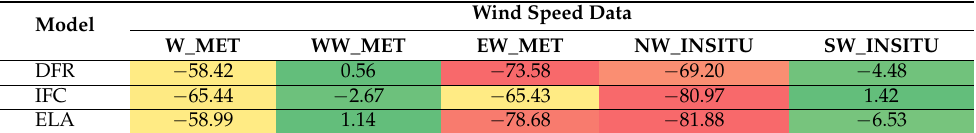
Table 4. MBE values for each combination in P_1_T. The colors of the scale refer to each row, from the lowest (red) to the highest (green)